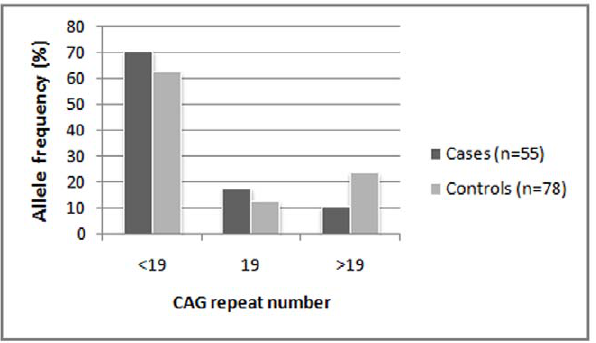
Figure 6. Distribution of CAG alleles with 60–100% activity among women with non-random X-Inactivation pattern.